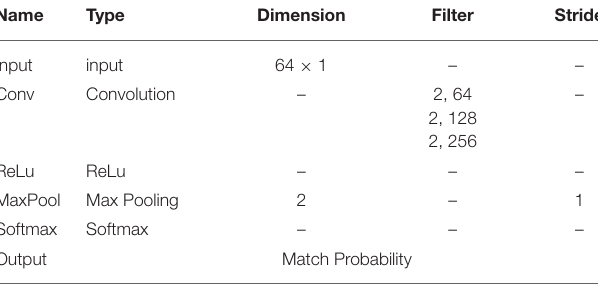
TABLE 1 | Model parameters for the CNNAI.